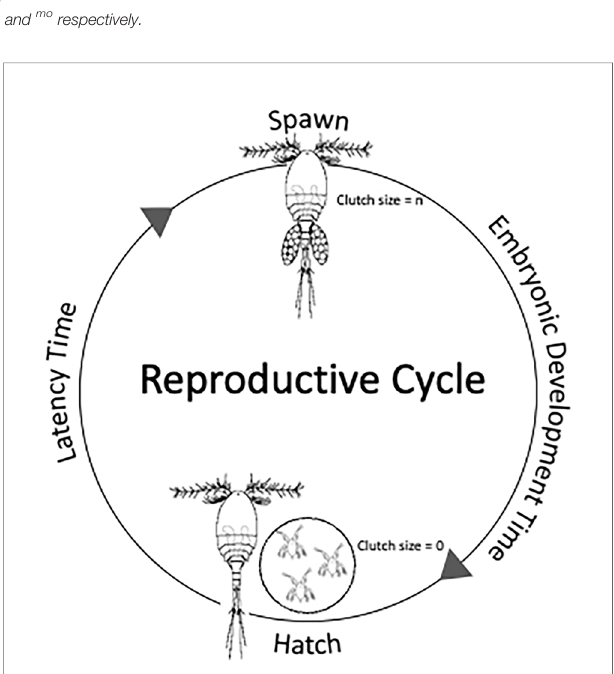
FIGURE 1 | Schematic representation of the reproductive cycle of the cyclopoida copepod Apocyclops royi . Females enter this cycle after molting from the last juvenile stage C5 and perform this cycle until their death de fi ned by their survival probability and longevity. The cycle integrates two main processes: the production (spawning) of a clutch of size n (Clutch size = n) and the hatching of the eggs. The time between hatching and spawning is de fi ned as Latency Time, and between hatching and spawning as Embryonic Development